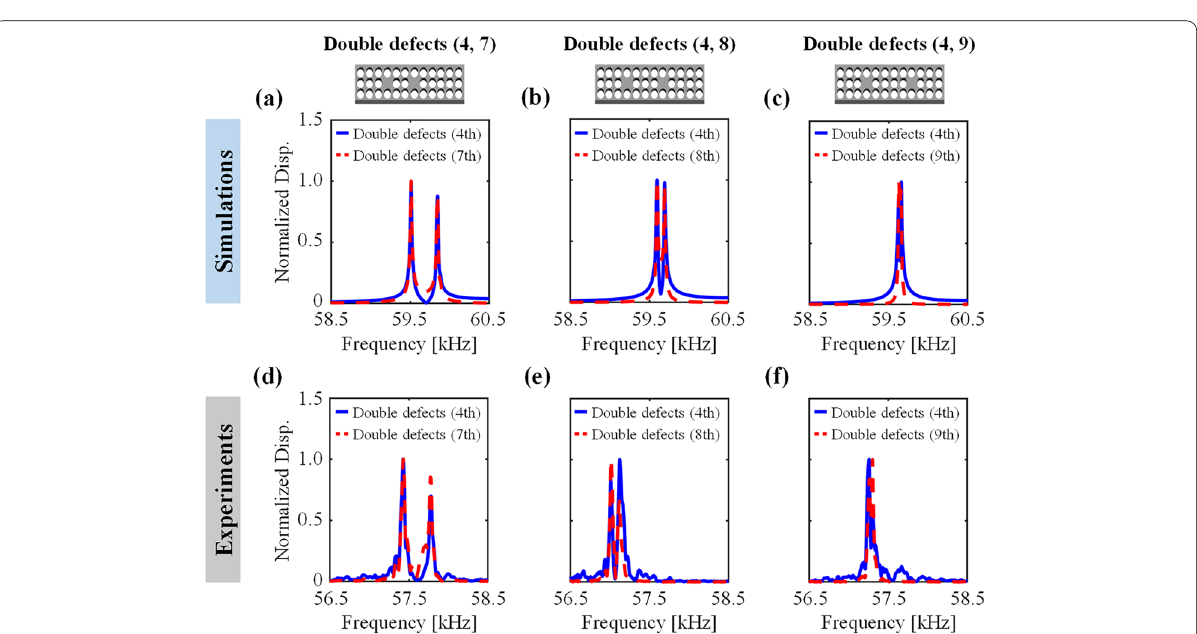
Fig. 4 The degree of the defect band splitting is observed to decrease with increasing distance between the double defects in both simulation and experiment. a – c Numerical simulation results of the normalized out‑of‑plane displacement frequency response functions for three cases of double defects (4, 7), (4, 8), and (4, 9), respectively. d – f Experimental results of the normalized out‑of‑plane displacement frequency response functions for three cases of double defects (4, 7), (4, 8), and (4, 9),